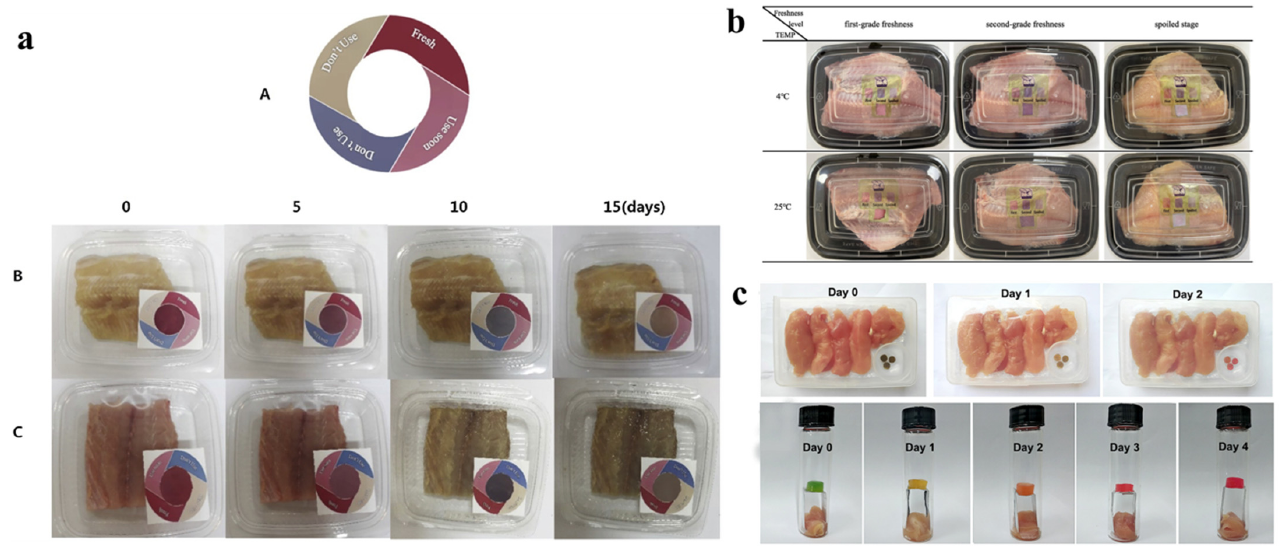
Figure 8. Application of nanocellulose indicator for food freshness monitoring: ( a ) fish, reprinted with permission from [136], 2019, Elsevier; ( b ) tilapia fillets, reprinted with permission from [167], 2022, Elsevier; ( c ) chicken breast, reprinted with permission from [135], 2020,